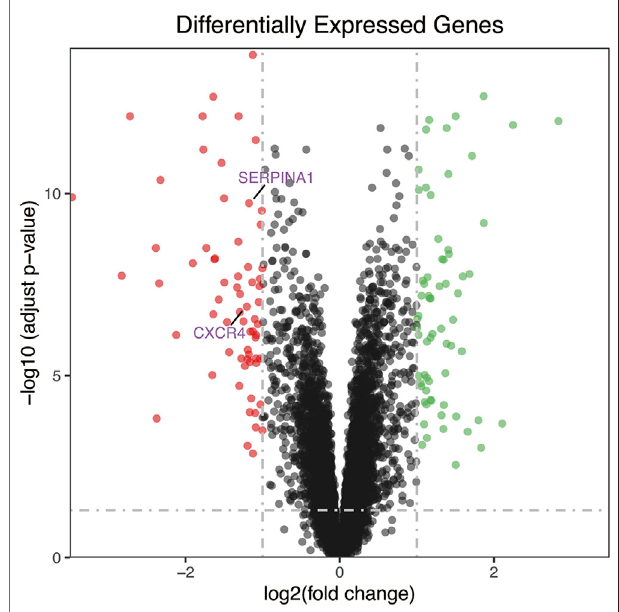
FIGURE 2 | The volcano plot of differentially expressed genes. Red dot represents upregulated genes from comparing OA with RA, while green dot represents downregulated genes. The number of differential encoded genes forboth upregulatedanddownregulatedgeneswas67.RA,rheumatoid arthritis; OA,